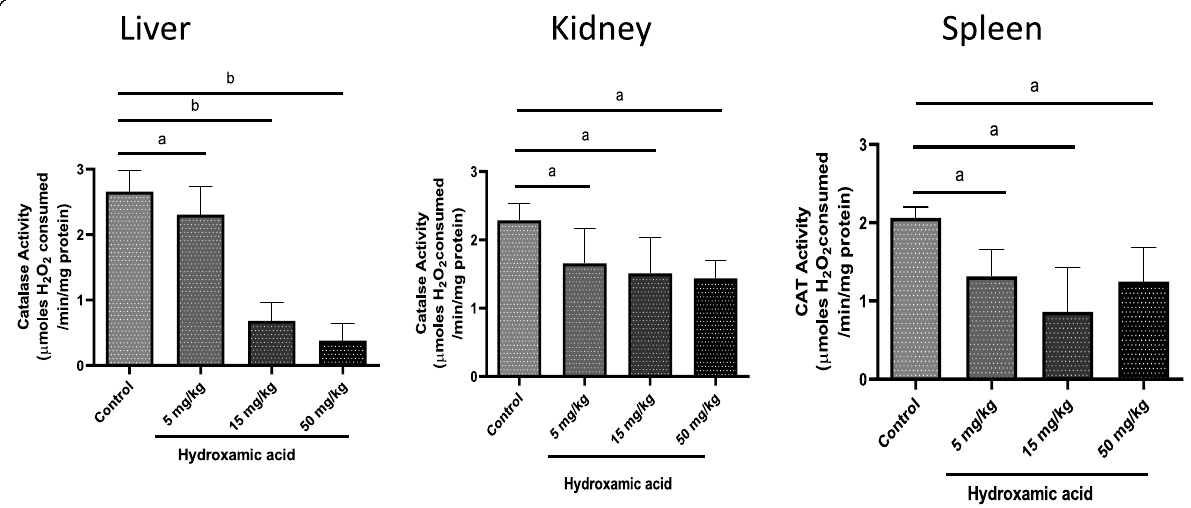
Fig. 2 Catalase activity in liver, kidney, and spleen. Values are expressed as mean ± SEM; ( n = 5).Different letters indicate significant difference at p <